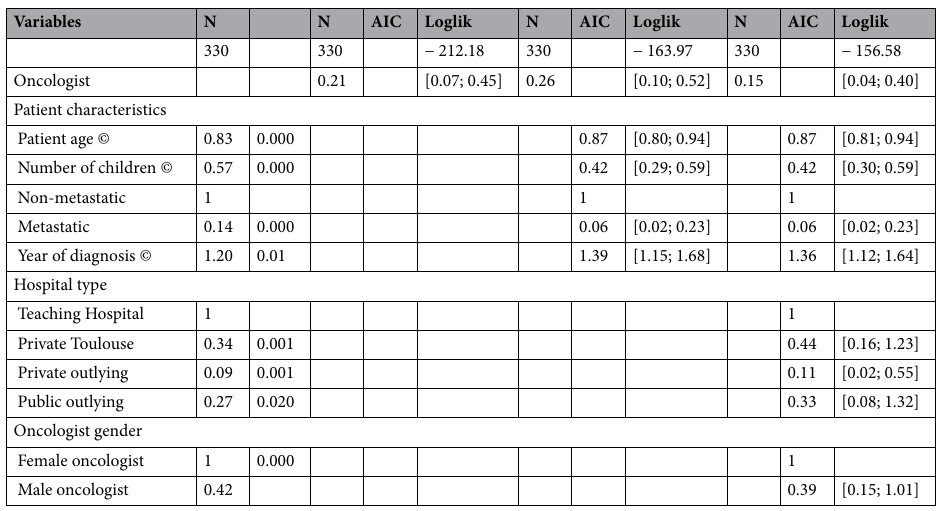
Table 2. Factors associated with transmission of fertility information (multilevel analysis). N unweighted number of cases, © continuous variable, OR Odds ratio, loglik log-likelihood ratio, AIC Akaike information criterion, ICC intraclass correlation coefficient, 95% IC 95% confidence